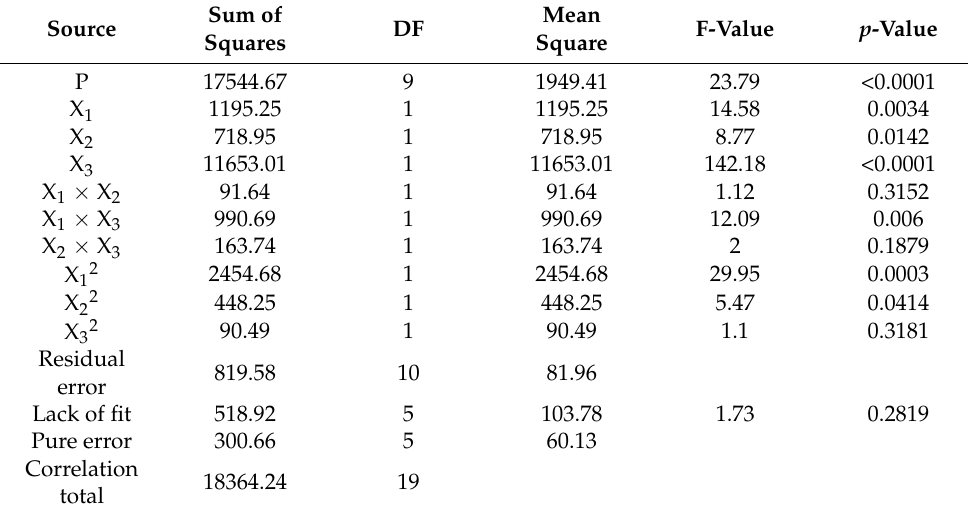
Table 5. Analysis of variance and coefficient estimation for a second-order model using the extract of Acer tegumentosum